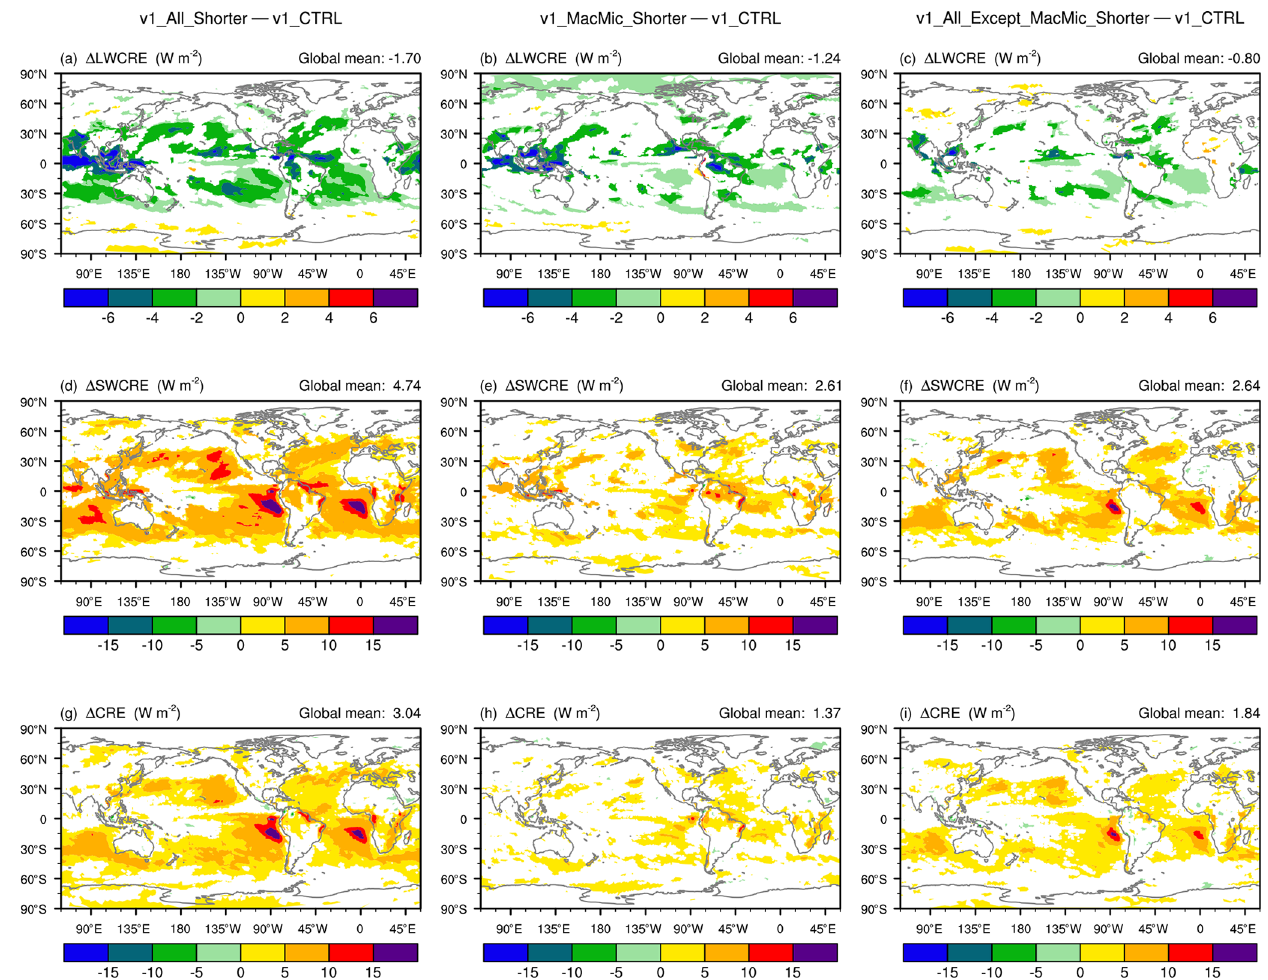
Figure 10. As in Fig. 9, but showing the longwave (LW, a, b, c ), shortwave (SW, d, e, f ), and total (g, h, i) CRE.